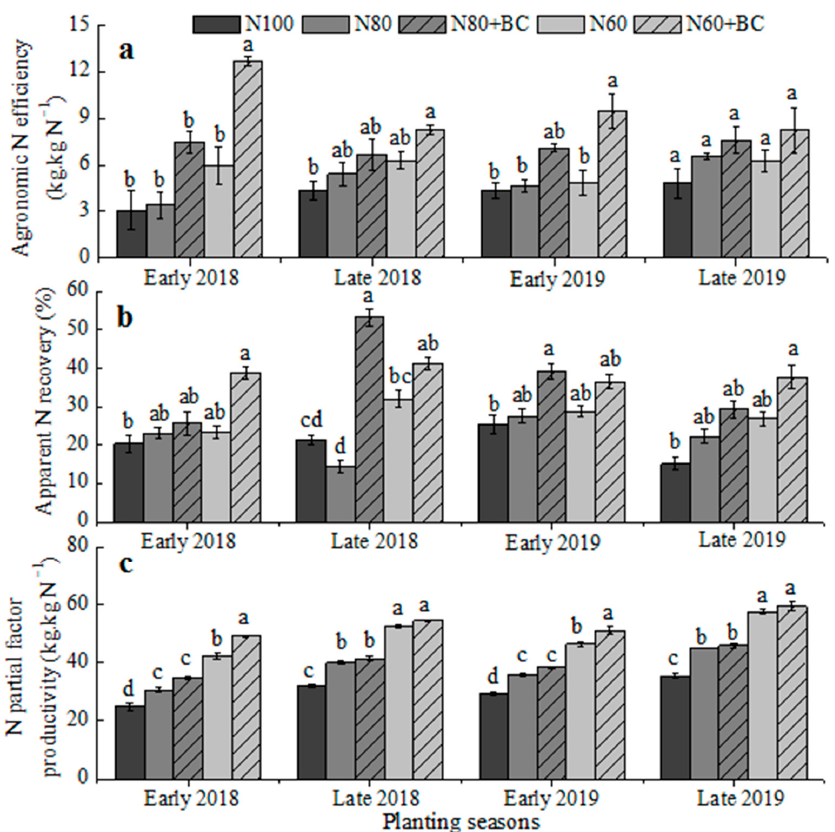
Figure 5. Effects of N fertilizer reduction combined with biochar application on N use efficiency of fertilizers. ( a ) Agronomic N efficiency, AE N ; ( b ) Apparent N recovery, AR N ; ( c ) N partial factor productivity, PFP N . N100, 180 kg N · ha − 1 ; N80, 144 kg N · ha − 1 ; N80+BC, 144 kg N · ha − 1 + biochar;